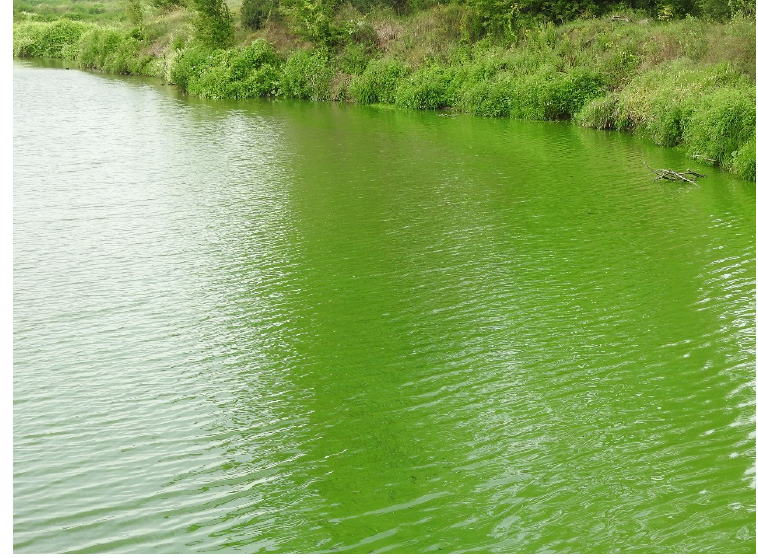
Figure 1. The water in the Vistula at the riverbank, summer.